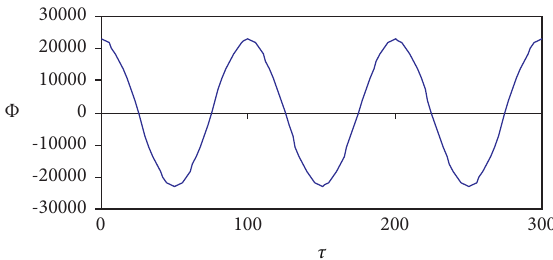
Figure 20: The analytical solution β for case (ii) in Section